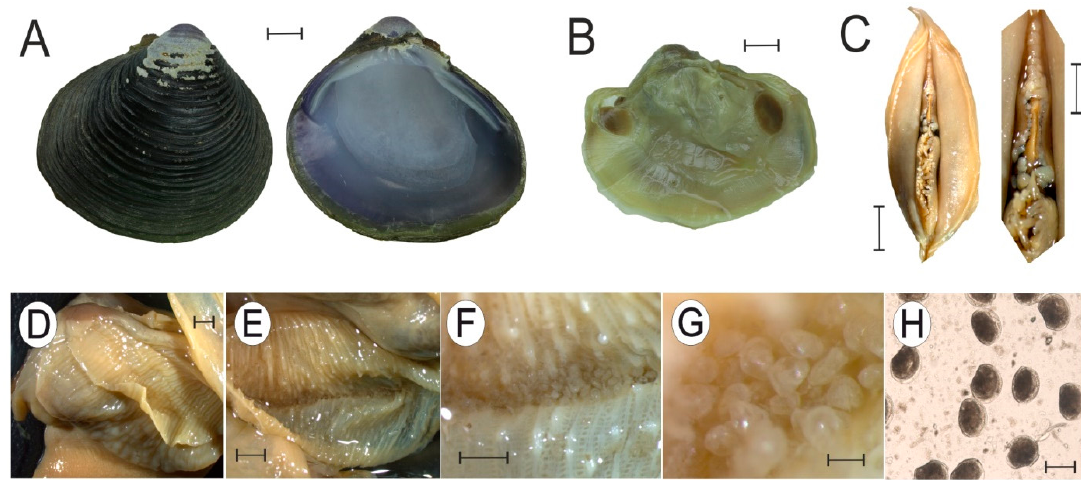
Figure 4. Shell morphology, anatomy, and larvae of Corbicula form R: ( A ) external and internal view of shell, left valve; ( B ) anatomy of soft body; ( C ) siphons morphology; ( D ) general view of gills; ( E ) gills of the incubating specimens; ( F ) larvae in the outer demibranch; ( G ) larvae inside of gill; ( H ) larvae D-shaped configuration.